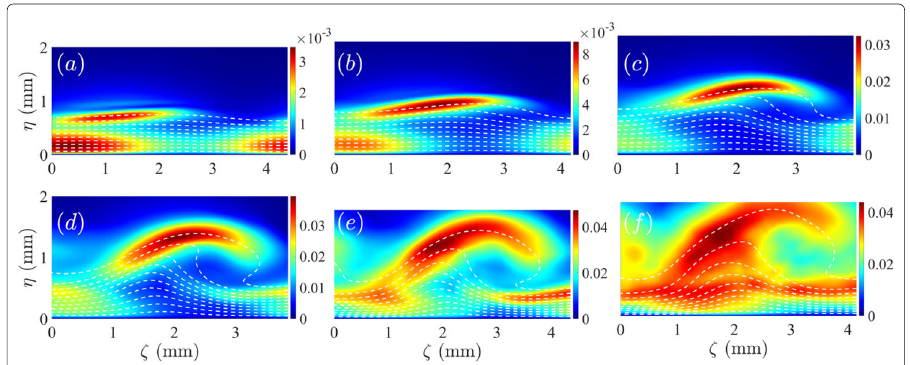
Fig. 11 The same as Fig. 10 but for the r.m.s. of axial velocity with frequency between 250 kHz and 550 kHz